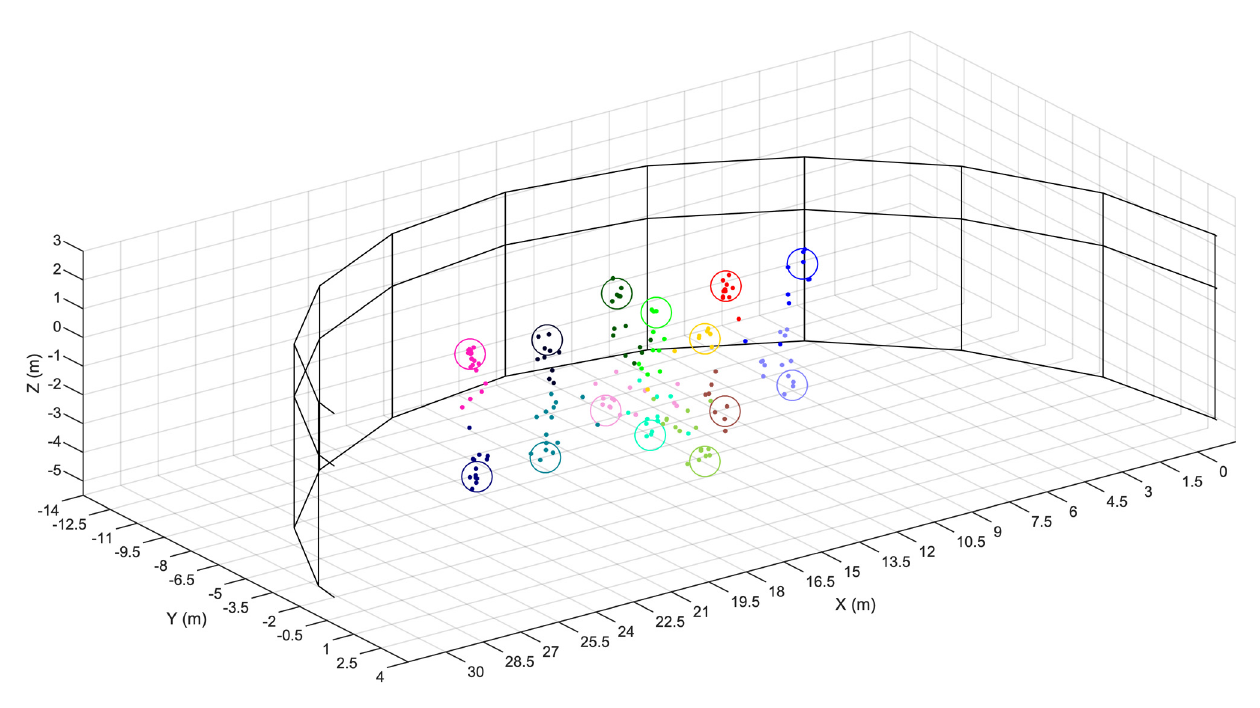
Fig 5. Predictions of test set source coordinates by Gaussian process regression models. The half-cylindrical National Aquarium EP is depicted. Large unfilled circles indicate the true source coordinates of the test snippet tonals; each has a unique color. Small filled circles indicate the source coordinates of test snippet tonals predicted by Gaussian process regression, colors matching their respective true coordinates.